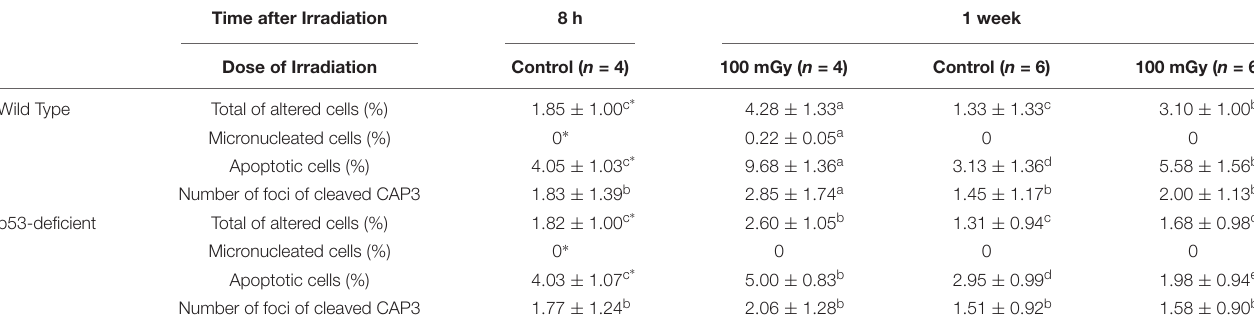
TABLE 1 | Percentage of altered, micronucleated, apoptotic erythrocytes (mean ± SD) per 100 erythrocytes in the irradiated medaka ( O. latipes ) after the low dose (100 mGy in total) and low dose-rate irradiation (at 9.92 µ Gy/min for 7 days) of gamma-rays. Time after